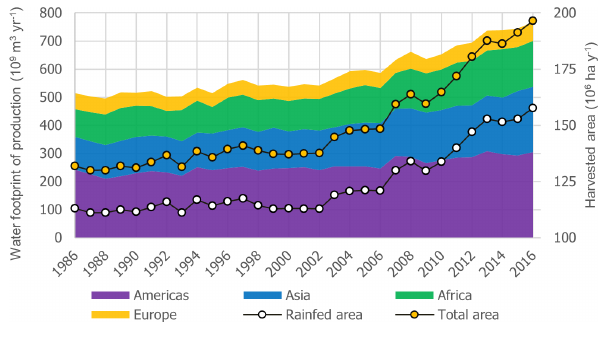
Figure 9. Trends in the regional water footprints of production (10 9 m 3 yr − 1 ) and global harvested areas (10 6 hayr − 1 ) of maize from 1986 to 2016. Oceania is not shown due to its negligible con- tribution. Note that the right y axis does not start at